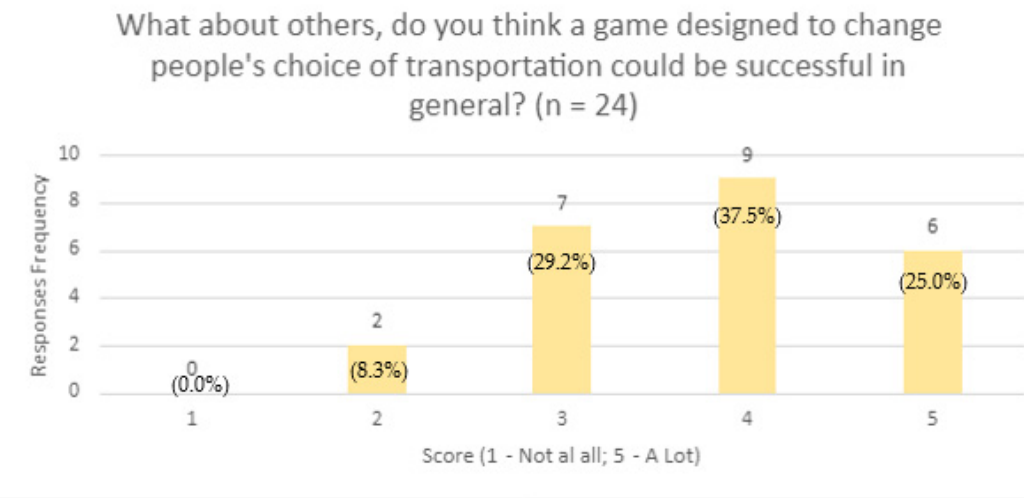
Figure 11. Potential success of persuasive games.